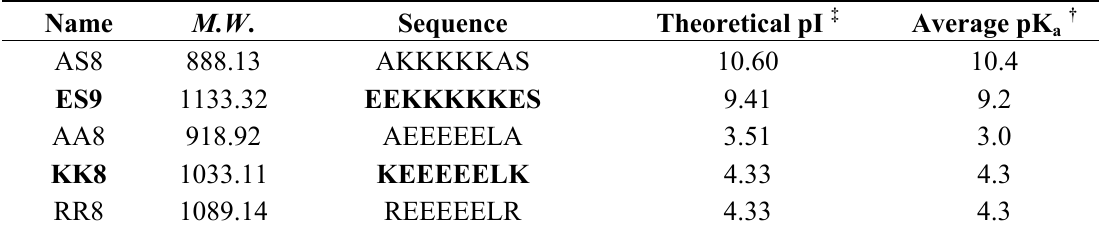
Table 1. Synthetic peptide sequences § .